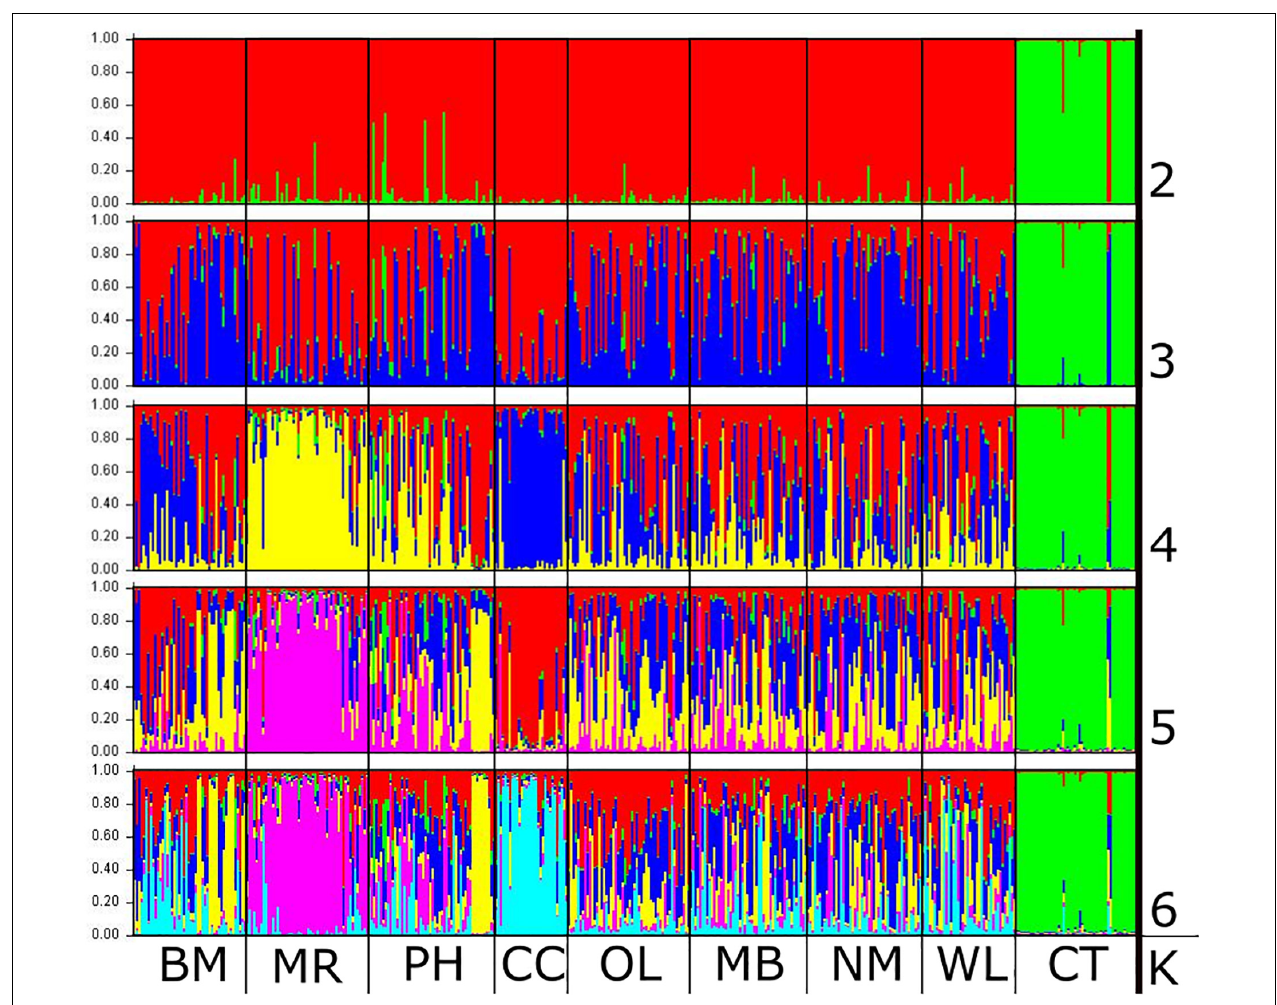
FIGURE 2 | Summary bar plots of estimated membership coefficient (Q) of the studied individuals from nine red oak populations for K 2-6 from STRUCTURE analysis using the default model where population locations were not considered (no LOCPRIOR). BM, Brockway Mountain; MR, McConnell Lake Road; PH, Phelps; CC, Crafts Cove; OL, Oak Lake; MB, Maitland bridge; NM, Nine Mile Woods; WL, Wentzells Lake; CT,